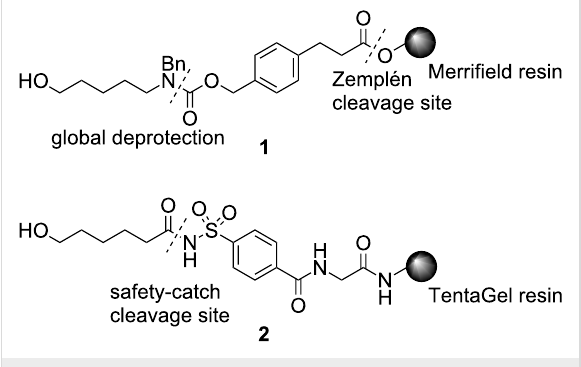
Figure 1: Structures of two novel linkers on different resins.